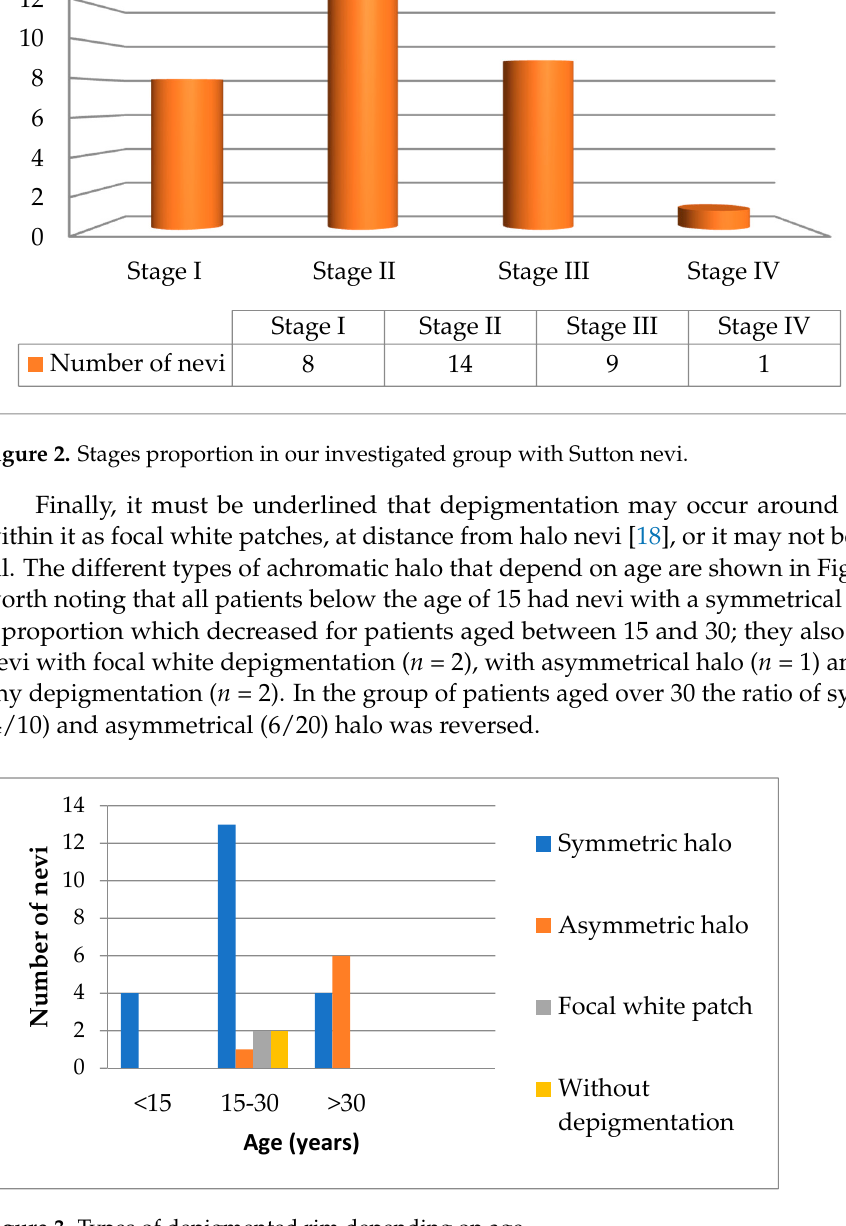
Figure 3. Types of depigmented rim depending on age.